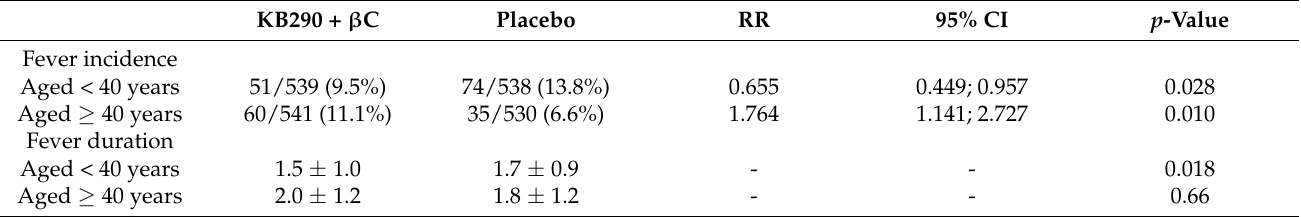
Table 4. Fever incidence and fever duration as the primary endpoints, sub-grouped according to age 1 . KB290 + β C Placebo RR 95%